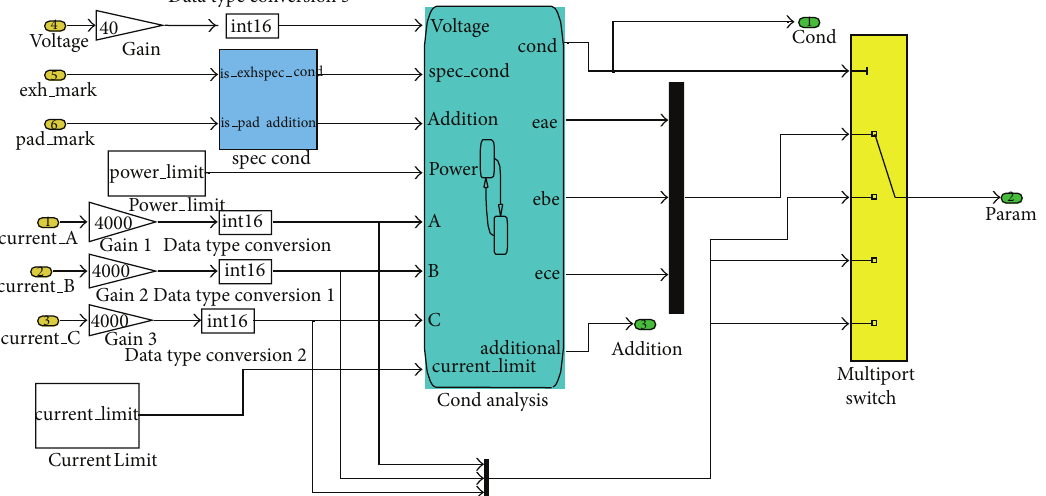
Figure 10: Internal details of operating condition identification module.